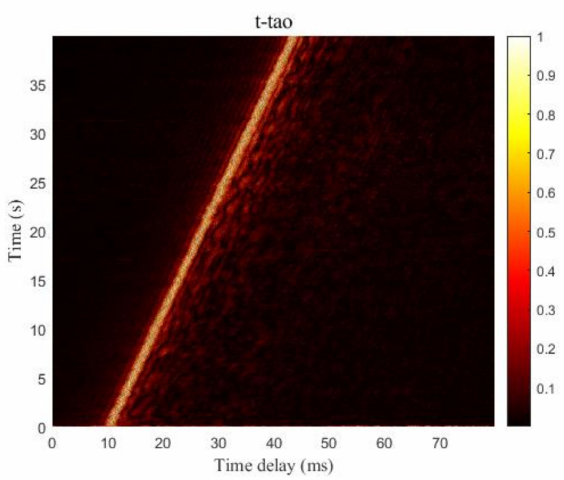
Figure 13. Time-varying channel impulse